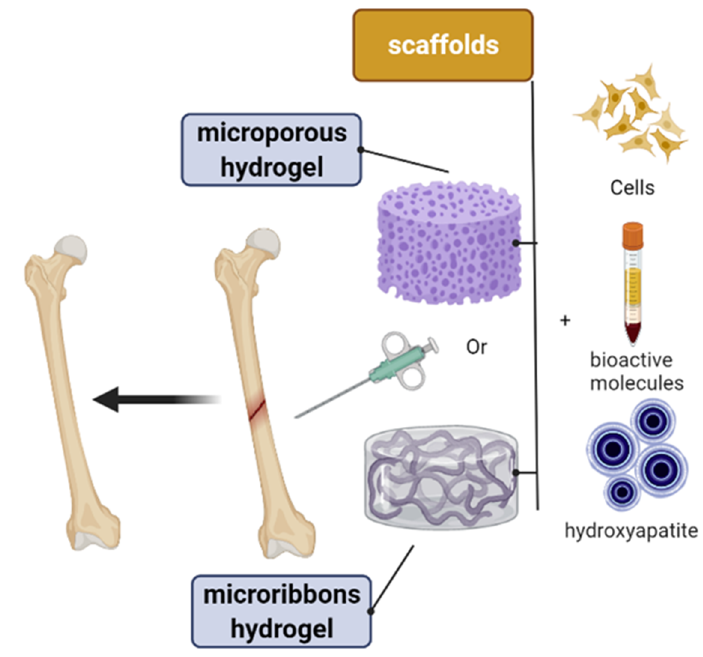
Figure 6. Using natural polymers of polysaccharide as a scaffold hydrogel in bone tissue engineering (BTE).